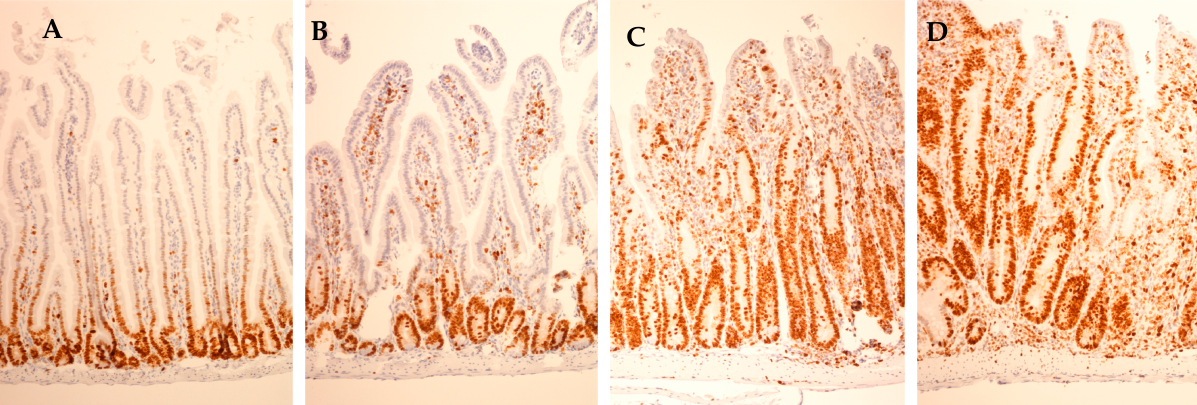
Figure 5. Histological sections of duodenum stained for Ki-67, representative of different duodenitis severity scores. ( A ) Histological duodenitis score 0, ( B ) score 3, ( C ) score 6 and ( D ) score 8. Proliferating epithelial cells and other dividing cells within the lamina propria stained brown (original magnification 100×). Note the extension of the proliferating crypt epithelial zone along the crypt/villus axis with increasing duodenitis scores.